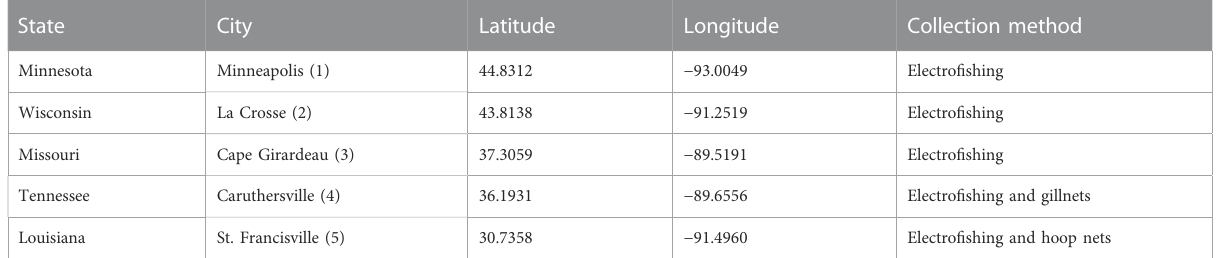
TABLE1Samplinglocationsandmethods usedtocollect fi shsamples.The number inparentheses behindthecity namecorresponds tothe locationnumbers on the map in Figure 1. Sampling dates varied by location, but can be found in Supplementary Data